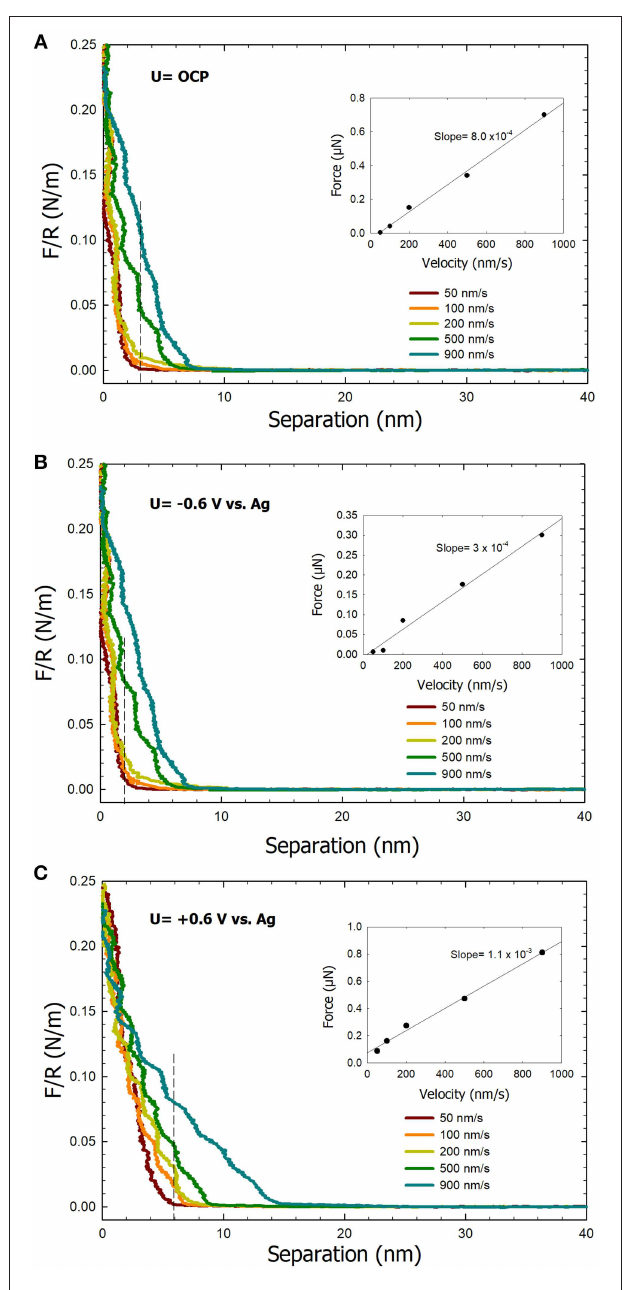
FIGURE 5 | Normal force curves recorded between a colloidal AFM probe and an ultra-smooth gold electrode surface at the various tip approach velocities in 0.1M NaCl as the electrolyte at (A) open circuit potential, (B) − 0.6V, and (C) + 0.6V. The inset plots correspond to force vs. velocity data at a specific separation distance (denoted by the dashed